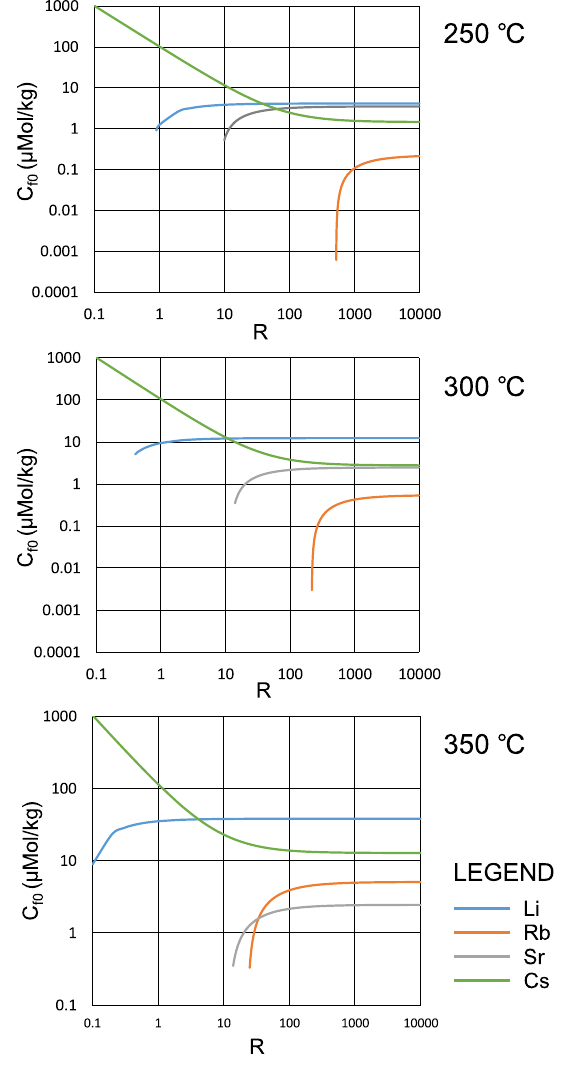
R at temperatures